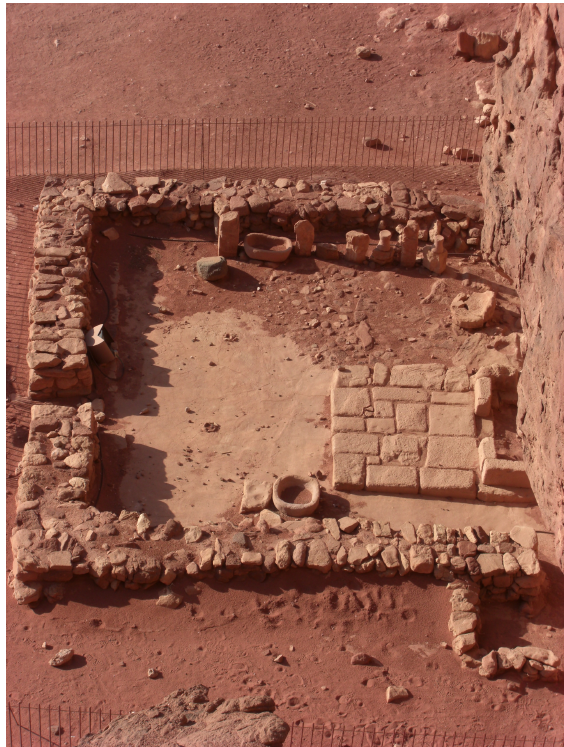
Figure 4 Temple of Hathor at Timna Site 200. View of the temple from the cliffs to the east. Photo by the author. It should be noted that the reconstruction of the photograph does not have very much to do with the excavation results.